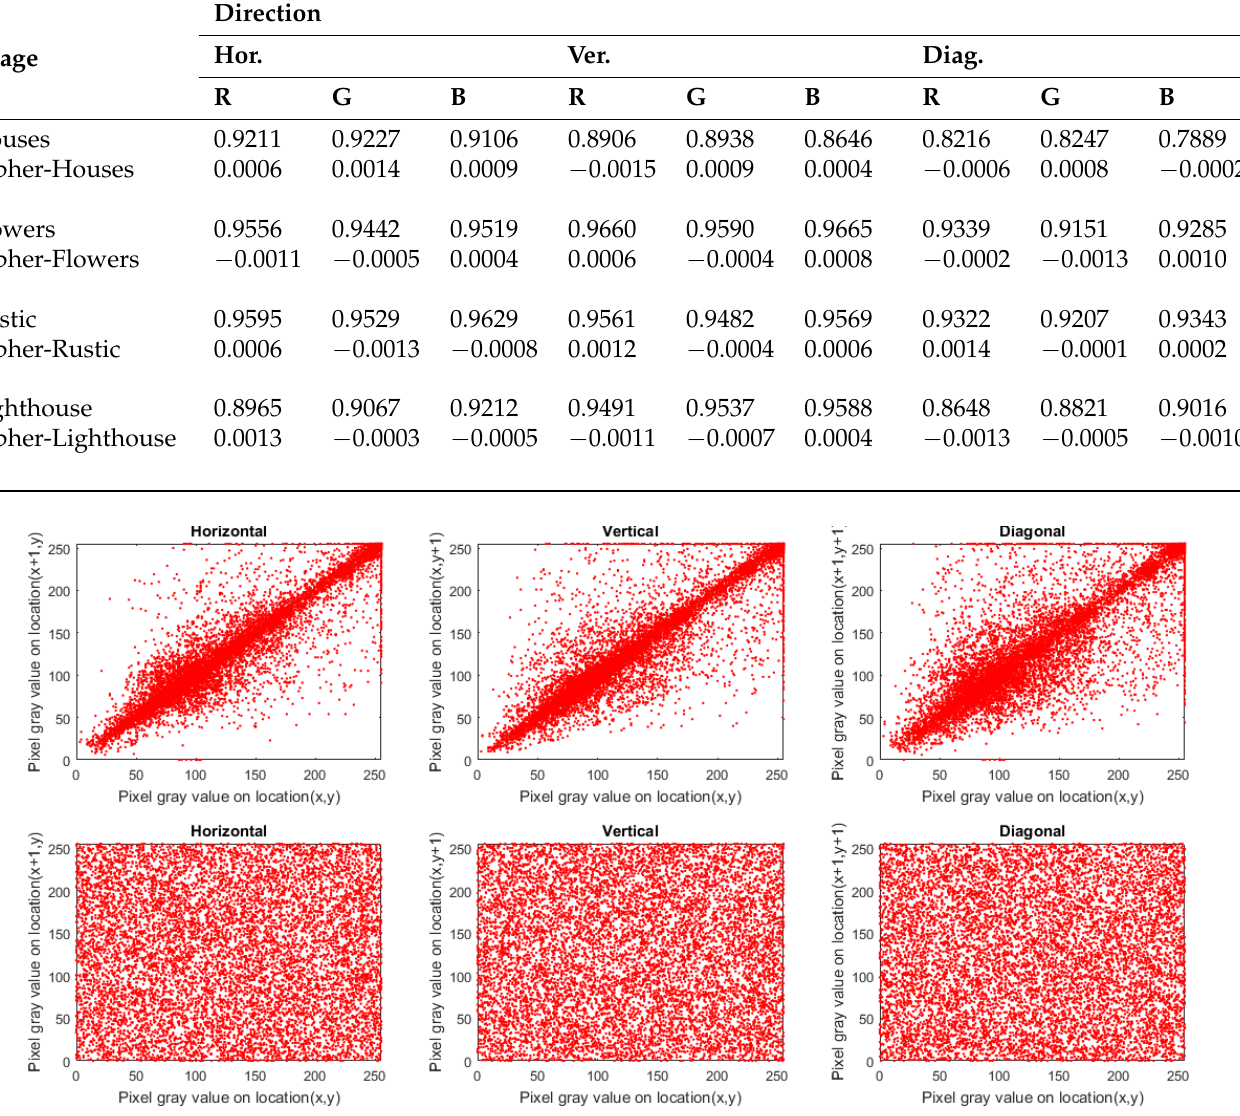
Table 12. Correlation values for combinations of images in the dataset in Figure 3.